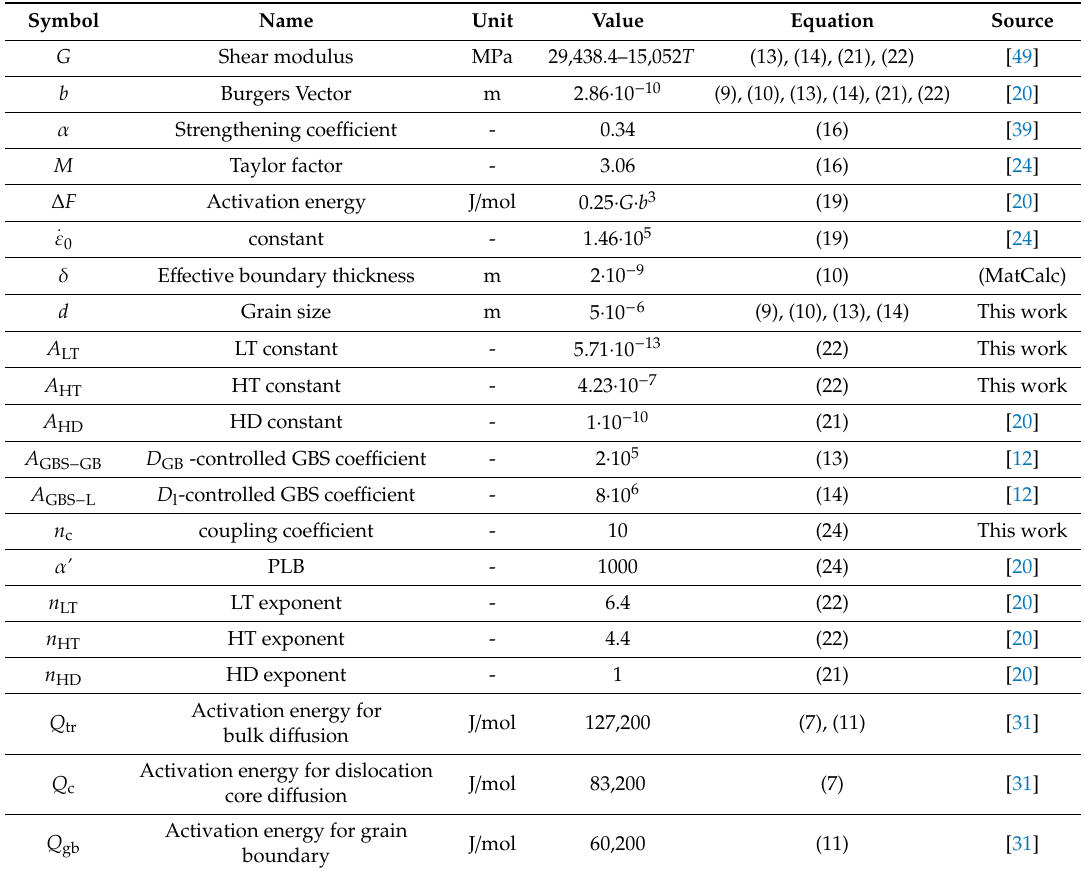
Table 1. Parameters to calculate each deformation